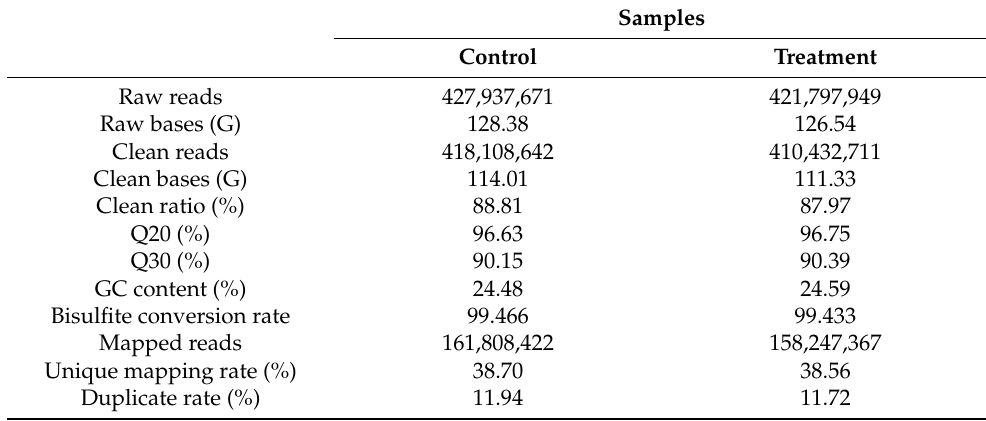
Table 1. Summary of bisulfite